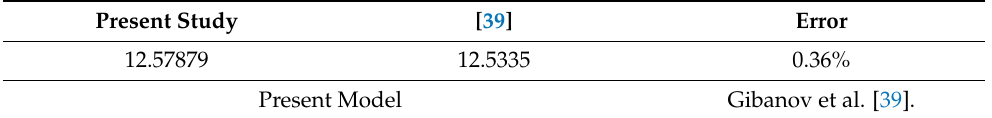
Table 2. Validation of the code of average Nu with [39]. Adapted with permission from ref. [39]. Copyright 2017 Springer